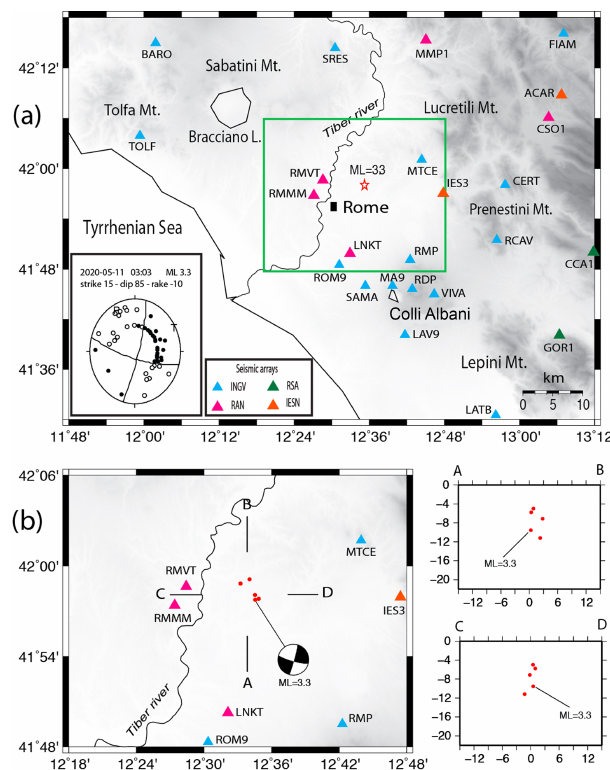
Figure 4. (a) Distribution of the seismic stations of the Italian National Seismic Network (RSN) of the Istituto Nazionale di Ge- ofisica e Vulcanologia (INGV) and of the regional seismic network of Lazio and Abruzzo (RSA) used to locate the epicenter of the 11 May 2020 event (red star). (b) Map and vertical distribution of the mainshock and two